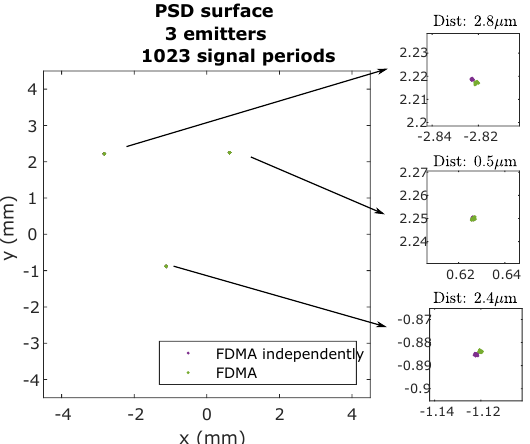
Figure 22. Impact points on the PSD surface using FDMA and using independently emitted BPSK sequences. The same procedure was done for CDMA-BPSK, and the results are shown in Figure 23 for 8- and 10-bit sequences. The distance shown in Figure 23 is the distance between BPSK, emitting the three emitters simultaneously and correcting the interferences with PIC algorithm respect to BPSK emitting the three signals independently (no simultaneously).